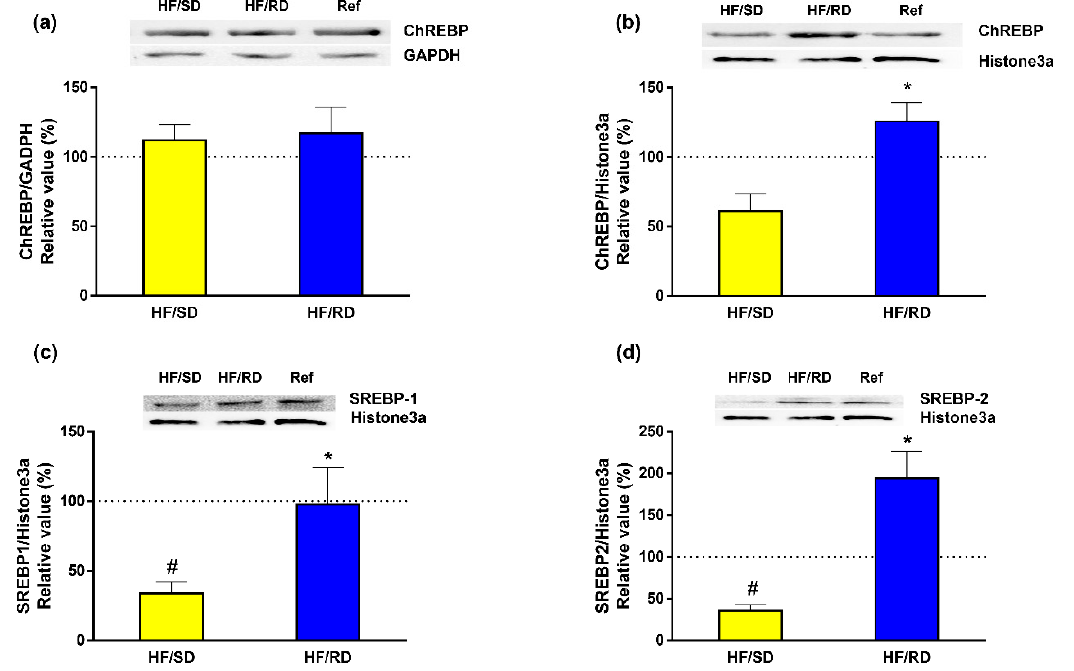
Figure 7. Carbohydrate-response element-binding protein (ChREBP) and sterol regulatory binding protein 1 and 2 (SREBP1 and SREBP2) expression in the liver. Total cellular ( a ) and nuclear ( b ) ChREBP content was analyzed by western blot. Nuclear expression of SREBP1 (c) and SREBP2 (d) was measured by western blot. Results were referred to rats (100% value). Results are mean ± SEM ( n = 6 animals per group). * p < 0.05 compared to the HF–SD group; # p < 0.05 compared to reference group. Glyceraldehyde-3-phosphate Dehydrogenase, GADPH.